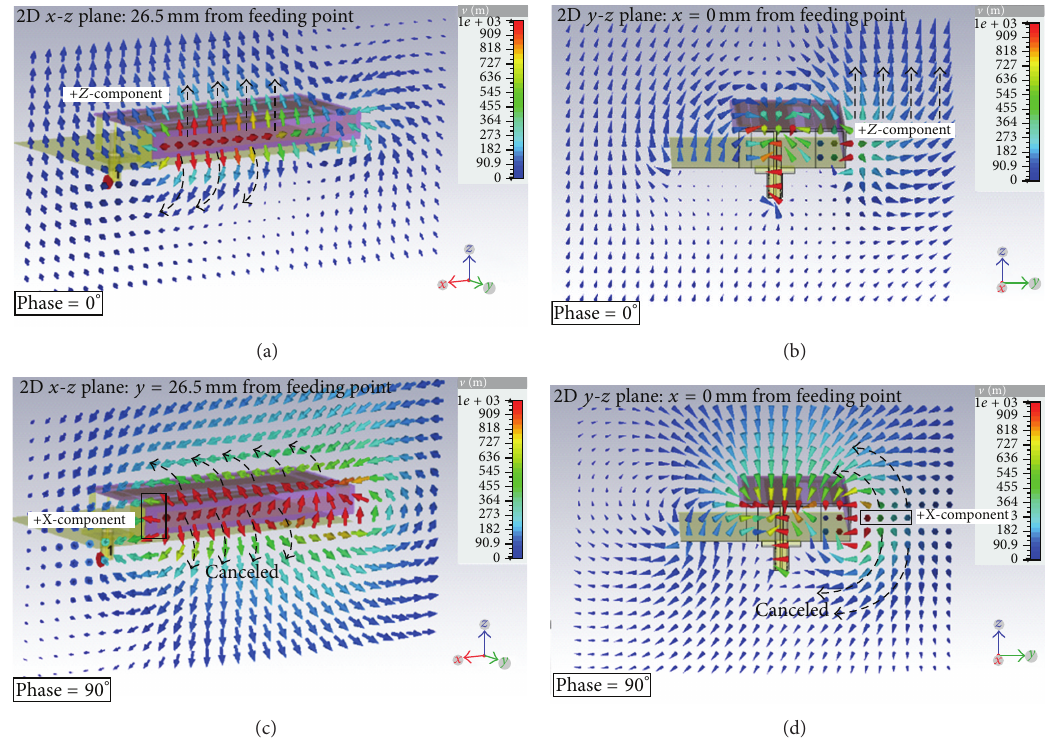
Figure 6: Electric field distributions in different phases at 920MHz (a) in the x-z plane at phase = 0 ∘ , (b) in the y-z plane at phase = 0 ∘ , (c) in the x-z plane at phase = 90 ∘ , and (d) in the y-z plane at phase = 90 ∘ .